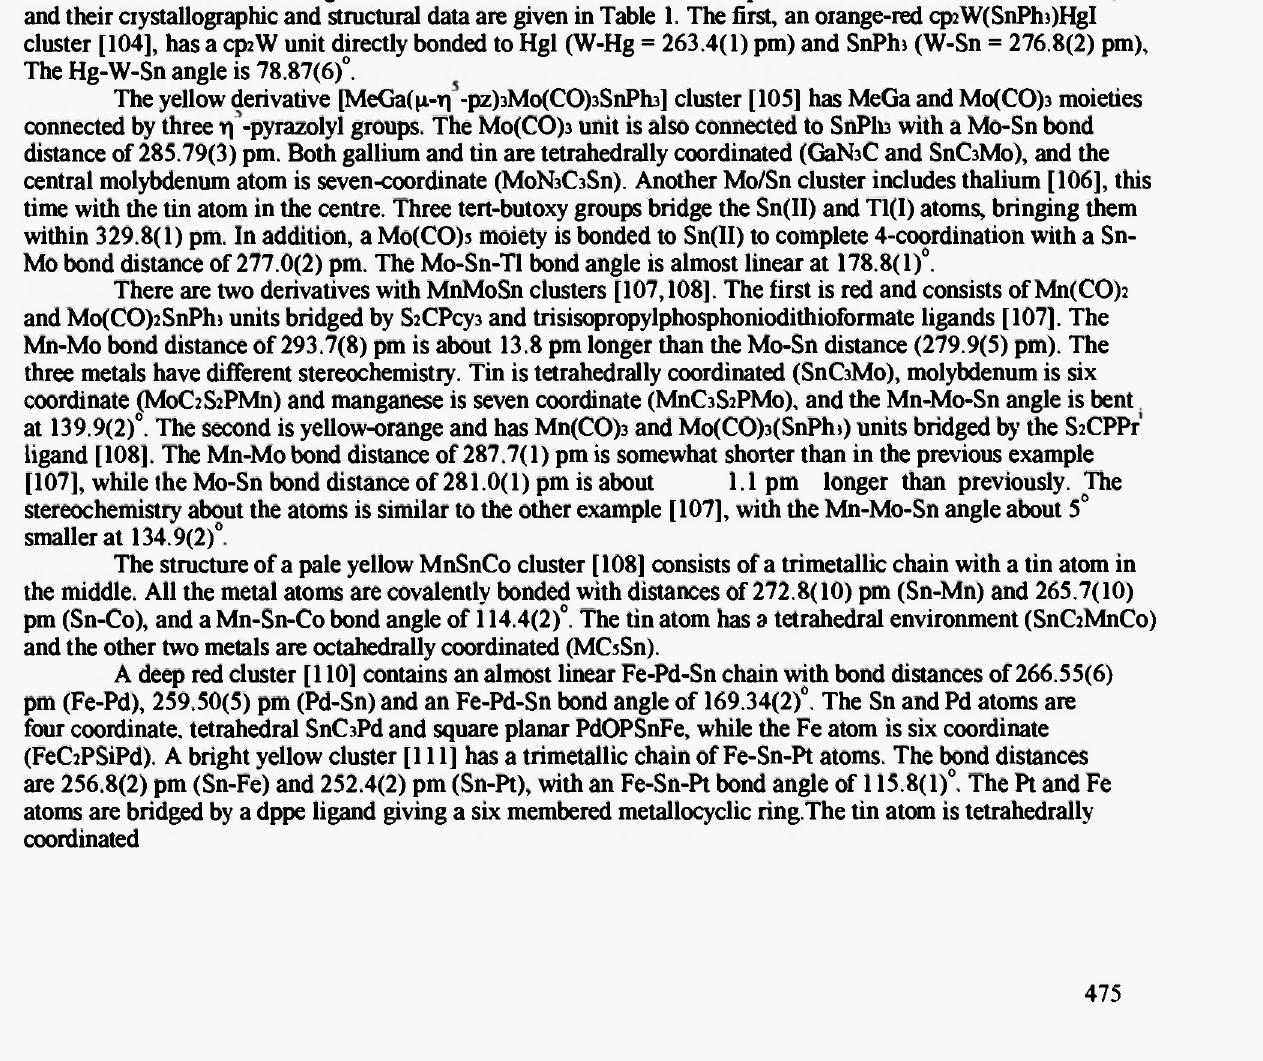
Fig. 4. Structure of (CO)«Ru2 ^-S )2Sn (tb)(tip)